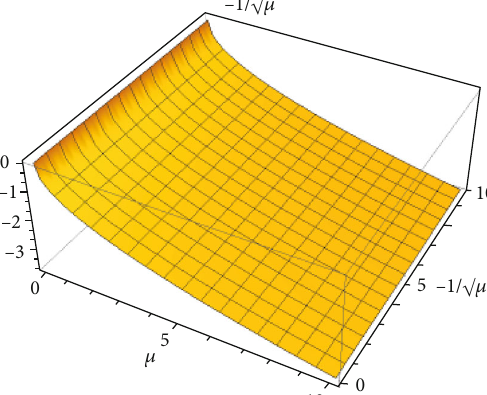
Figure 2: The graphical surface represents a 3-D view of F -contractive function F ð u Þ = − 1/ and w ∈ ℝ +